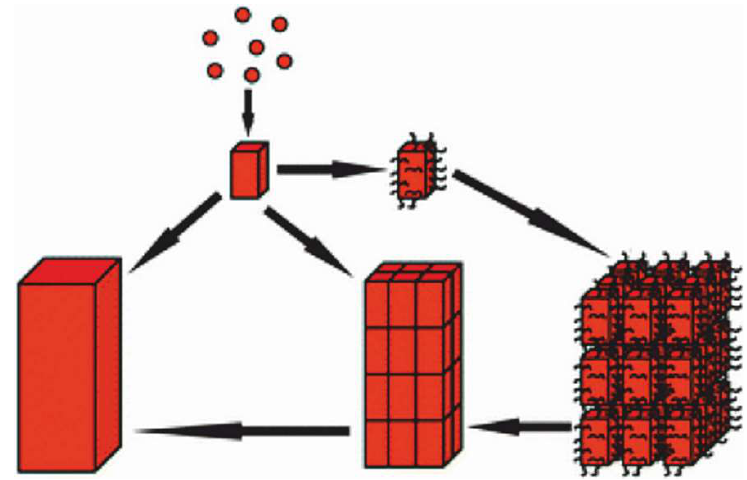
Figure A1. Scheme of mesocrystal formation by accretion of small crystalline units. Attraction due to chemical forces between their crystalline faces results in formation of the massive crystal. Credit picture [23].